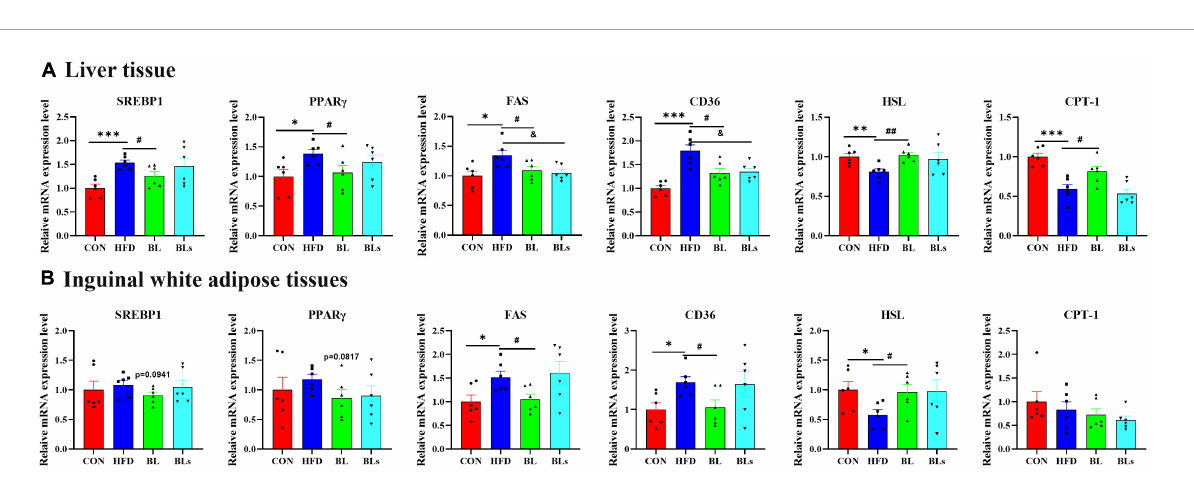
FIGURE4 Brevibacillus laterosporus BL1 treatment regulated the mRNA expression levels of lipid metabolism-related genes in HFD-fed mice. (A,B) Relative mRNA expression levels of SREBP1, PPAR γ , FAS, CD36, HSL, and CPT-1 in the liver and inguinal white adipose tissue. Data are presented as mean ± SEM ( n = 6) and analyzed using one-way ANOVA. Significant differences between HFD and CON are indicated by ∗ p < 0.05, ∗∗ p < 0.01, and ∗∗∗ p < 0.001. Significant differences between HFD and BL are indicated by # p < 0.05 and ## p < 0.01. Significant differences between HFD and BLs are indicated by & p <